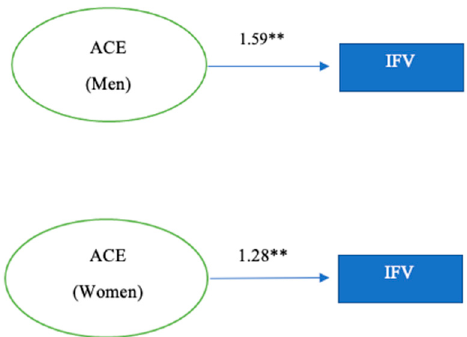
Figure 3. Regression model: intrafamily violence in men and women p < 0.001 ** .